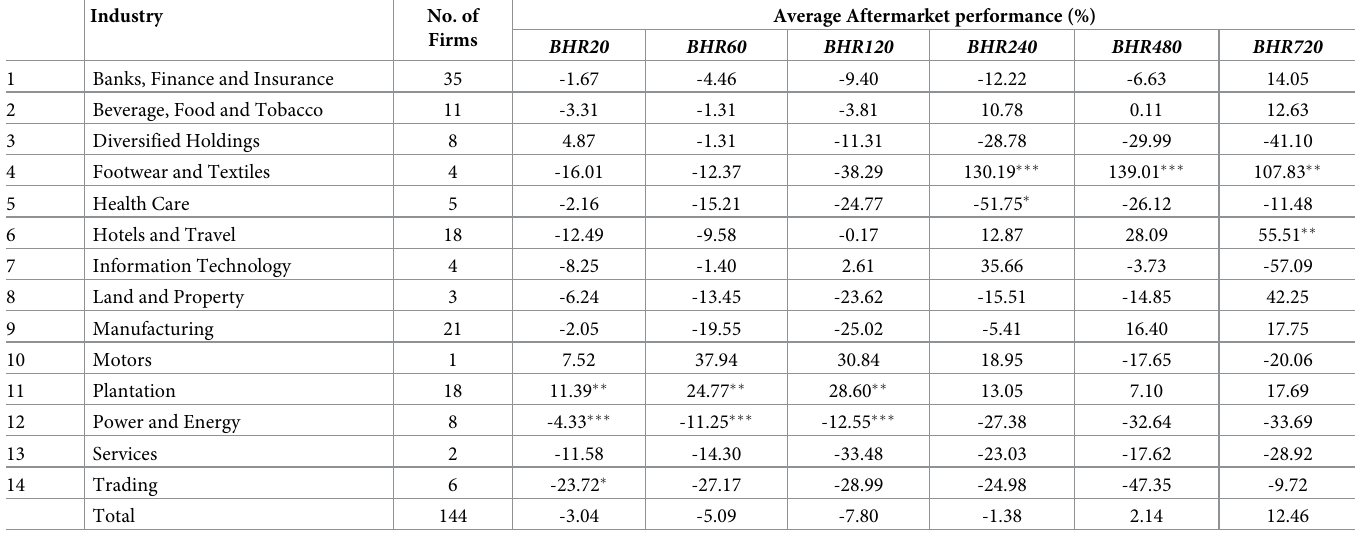
Table 5. IPO performance by